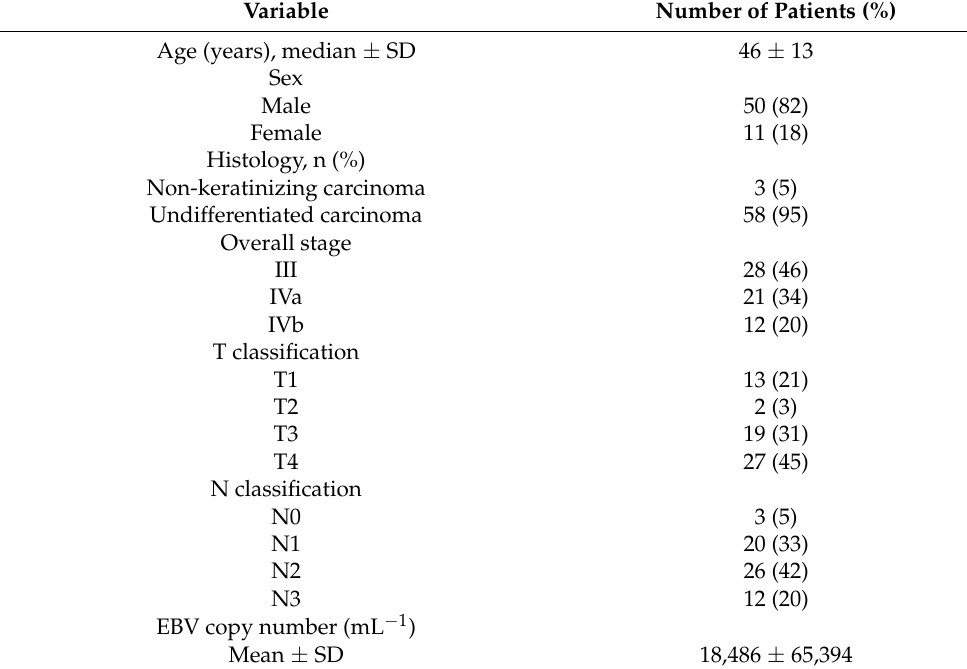
Table 1. General characteristics of the study participants ( n =